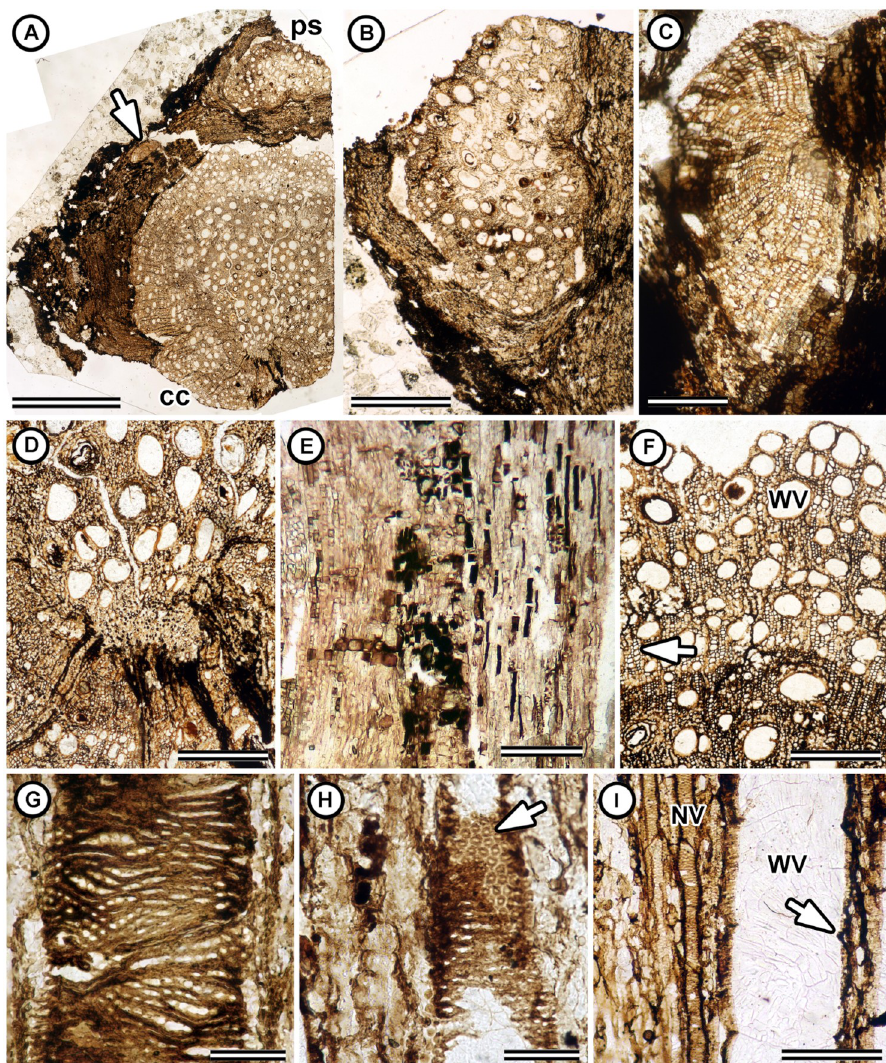
Fig 2. Cambial variant and vessel characters in Ampelorhiza heteroxylon . (A) Transverse section of the stem showing diffuse-porous wood of the central cylinder (cc) and peripheral vascular strands (ps) in the external tissues. Arrow indicates the position of the smaller of two peripheral vascular cylinders. Specimen UF 19391-63016 XS peel 10. (B) Close up transverse section of the larger of two peripheral vascular strands. Specimen UF 19391-63016 XS peel 10. (C) Transverse section of the smaller of two peripheral vascular cylinders. There is no pith. Specimen UF 19391-63016 XS peel 10. (D) Close up of A showing the primary vascular parenchyma. Specimen UF 19391-63016 XS peel 10. (E) Tangential longitudinal section through the tall cells of the primary vascular parenchyma (center right), ray cells (center left) and juvenile wood (far left). UF 19391-63016 LS peel 16. (F) Transverse section showing wide solitary vessels (WV) and narrow vessels in long radial multiples (at arrow). Specimen UF 19391-63026 XS peel 6. (G) Tangential longitudinal section (LS) showing coalescent pit apertures on the vessel wall. Specimen UF 19391-63016 LS peel 6. (H) Tangential longitudinal section showing alternate polygonal pits on the vessel wall (at arrow). Specimen UF 19391-63016 LS peel 7. (I) Tangential longitudinal section showing narrow vessels (NV) with oblique end walls, and wide vessels (WV) with simple perforation plates and end walls perpendicular to lateral walls (right arrow). Specimen UF 19391-63026 TLS peel 1. Scale bars: A = 3 mm; B = 1 mm; C, F, I = 200 μ m; D, E = 500 μ m; G, H = 100 μ m.